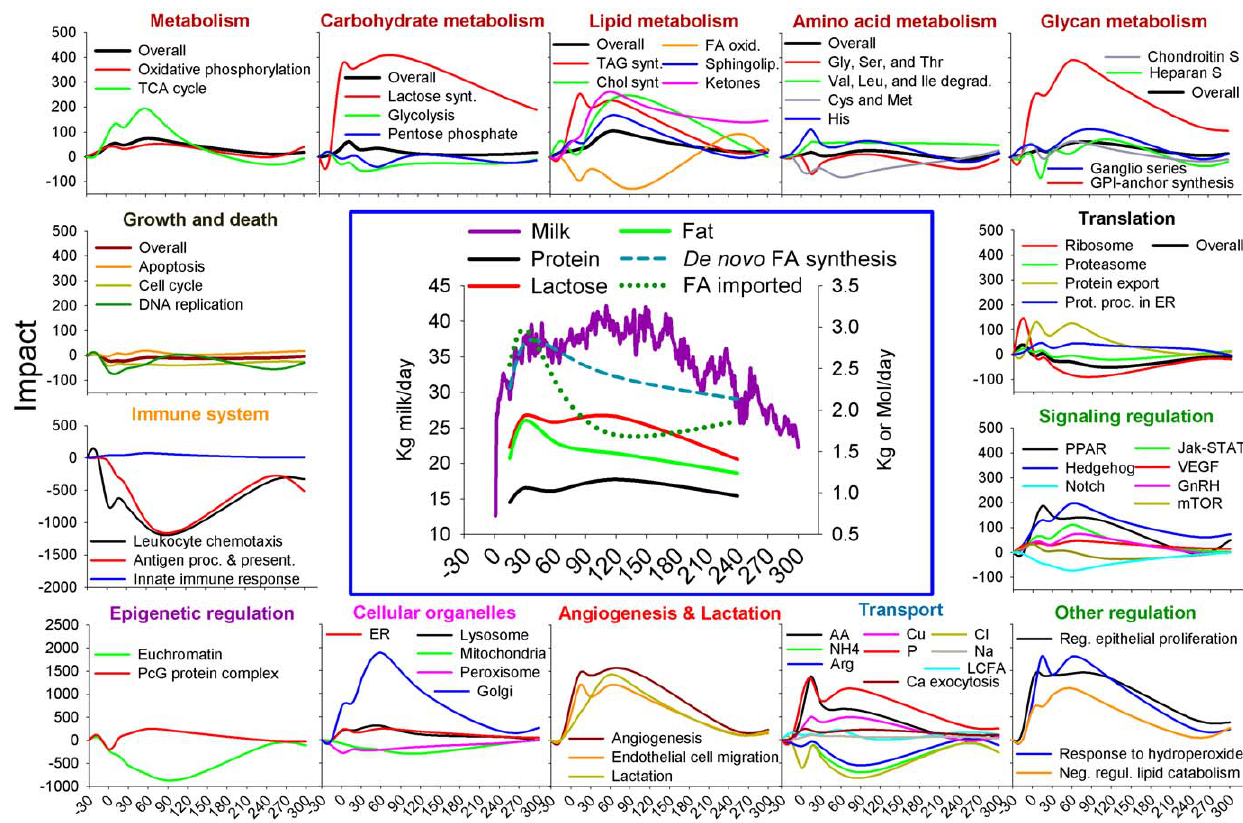
Figure 5. Summary figure of the most relevant biological functions in bovine mammary gland during the lactation cycle as revealed by the Dynamic Impact Approach (DIA) analysis of KEGG pathways and Gene Ontology terms (see Additional file S1 for details). Shown at the center are the curve of lactation, yield of main milk constituents (protein, lactose, and fat) [7,8], and estimates of fatty acid import and de novo synthesis [8]. Red titles are the most relevant metabolism as revealed by the KEGG pathway and Gene Ontology analysis. Other color titles denote main functions impacted during lactation. The large increase at the transcriptomic level of caseins or other milk proteins are not shown. The X-axis depicts the day relative to parturition and the Y-axis the direction of the impact as calculated by DIA. Legend: AA=amino acid; Arg=arginine; Ca=calcium; Chol=cholesterol; Cl=chloride; Cu=copper; Cys=cysteine; ER=endoplasmic reticulum; FA=fatty acids; GnRH=Go- nadotropin-releasing hormone pathway; Gly=glycine; GPI=Glycophosphatidylinositol; His=histidine; Ile=isoleucine; LCFA=long-chain fatty acids; Leu=leucine; Met=methionine; mTOR=mTOR=mammalian target of rapamycin signaling pathway; Na=sodium; NH4=ammonium; Notch=Notch signaling pathway; P=phosphate; PPAR=peroxisome proliferator-activated receptor signaling pathway; S=sulfate; Ser=serine; TAG=triacylglycerol; Thr=threonine; Val=valine; VEGF=vascular endothelial growth factor signaling pathway.